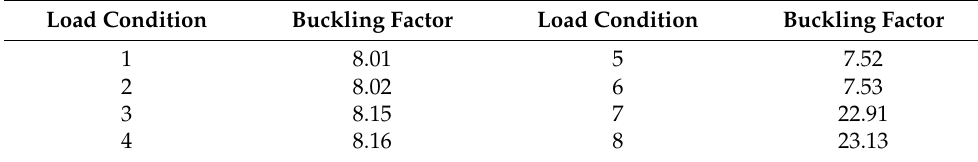
Table 9. First-order buckling factor of the towers for each load condition.